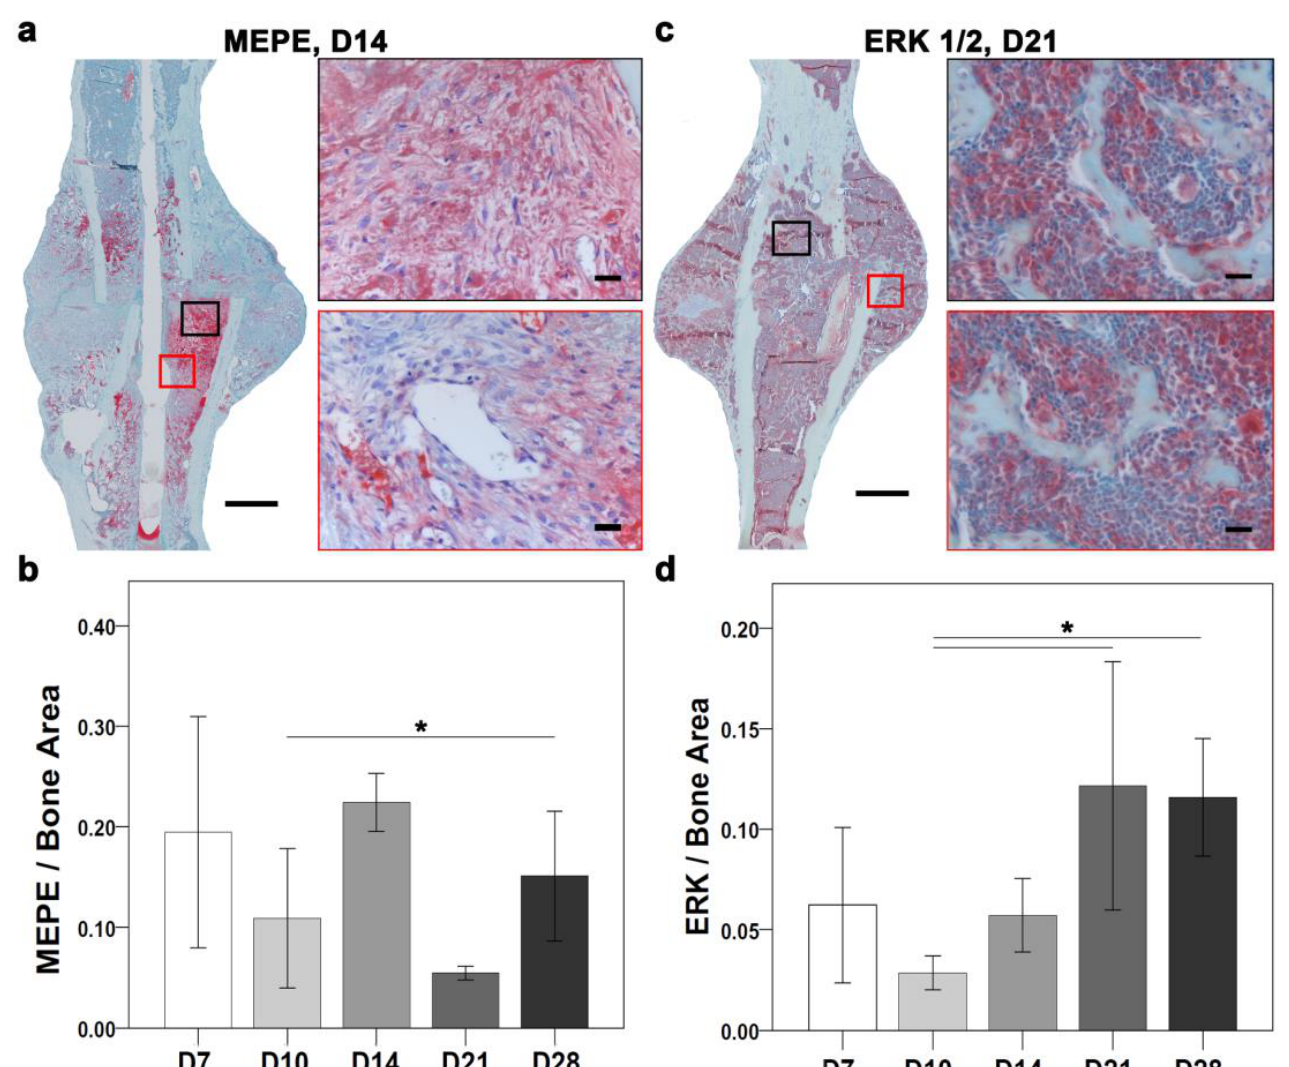
Figure 6. MEPE and ERK activity are directed toward the establishment of bone homeostasis during bone healing. ( a ) MEPE-positive signal was most clear around the callus and within the mineralized matrix at D14. ( b ) Quantitatively, MEPE-positive area was highest at D14 and lowest at D21. D10 showed a significantly lower MEPE-positive area compared with D28. ( c ) ERK-stained regions were distributed around the whole callus at D21. ( d ) ERK-stained area had the highest portion at D21 and the lowest at D10. However, the ERK-positive area was significantly lower at D10 compared with D21 and D28. (N: D7 = 4, D10 = 6, D14 = 3, D21, D28 = 5; red and black boxes represent higher magnification, non-parametric distribution with Mann-Whitney U-test; * ≤ p = 0.05, scale bar: ( a , c ) ( left : 250 µm, right : 25 µm)).